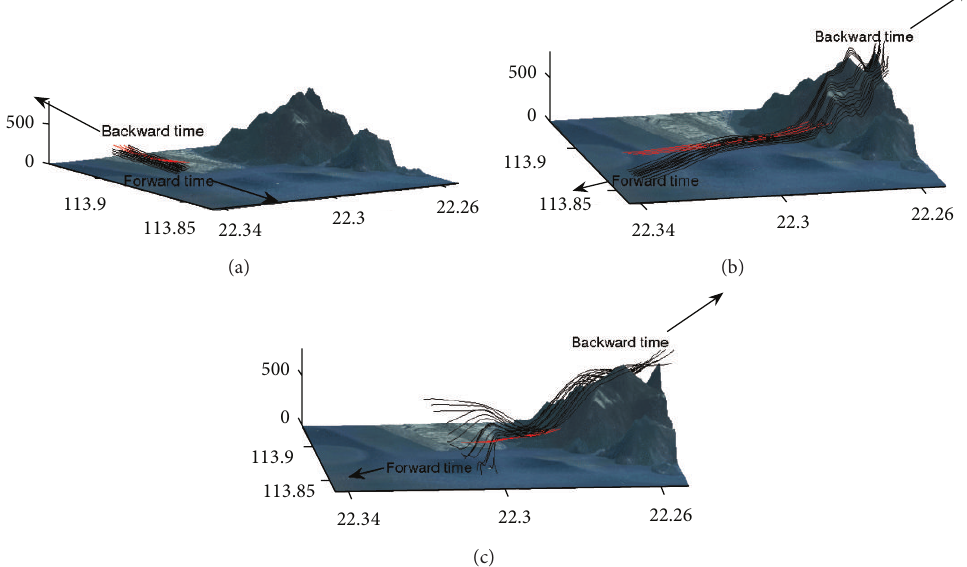
Figure 6: Trajectory comparison between 3D data and 2D data on the LIDAR cone. The panels are, from left to right, data from RAMS, FLOWSTAR, and WRF, respectively.